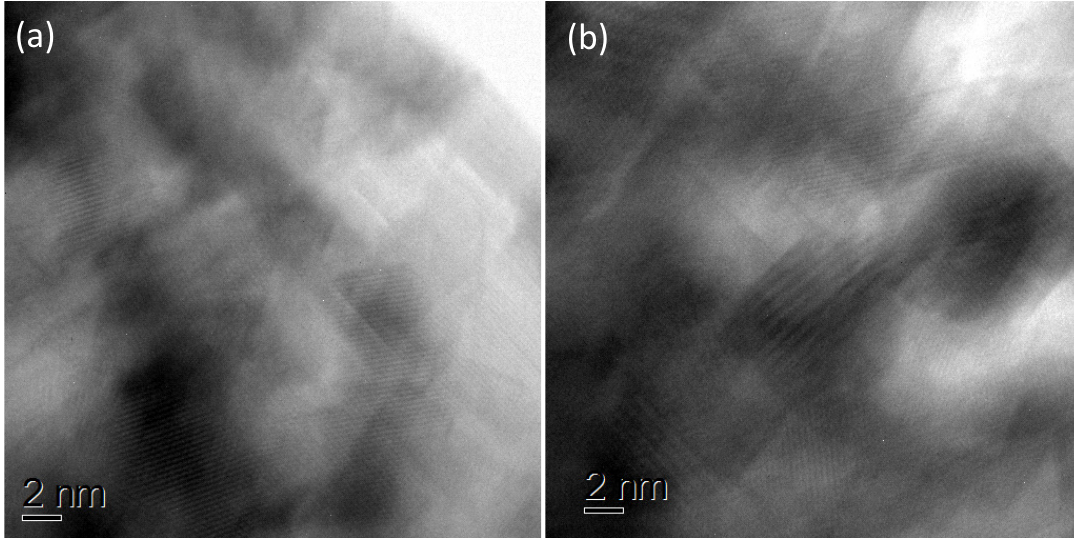
Figure 5. ( a , b ) High-resolution TEM images of two different areas. The fringes indicate the orientation of the